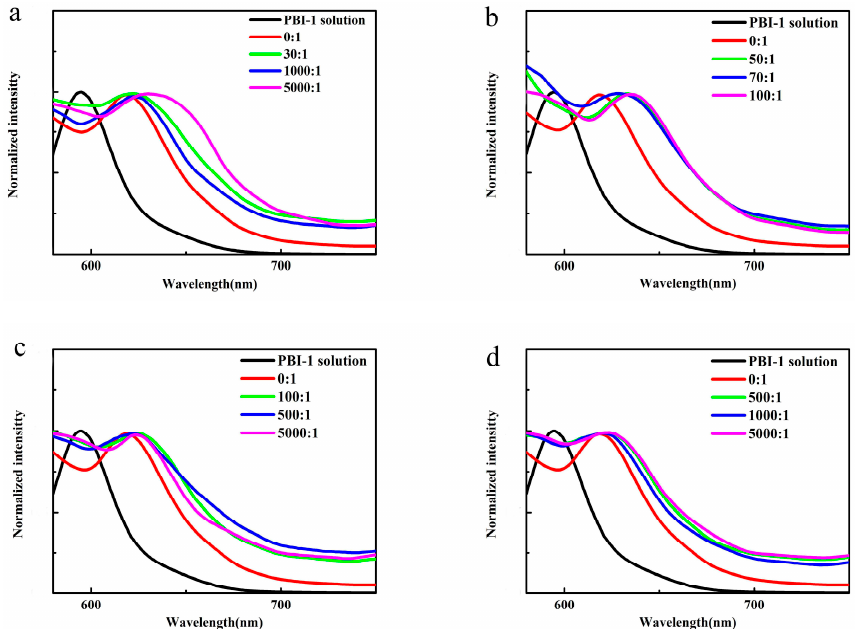
Figure 10. Normalized fluorescence emission spectra of PBI-1 solution and PBI-1 aggregates at different r values assembled in various organic acids. ( a ) p-Toluenesulfonic acid, ( b ) oxalic acid, ( c ) citric acid and ( d ) glutaric acid. λ ex = 440 nm was used to record the emission spectra.